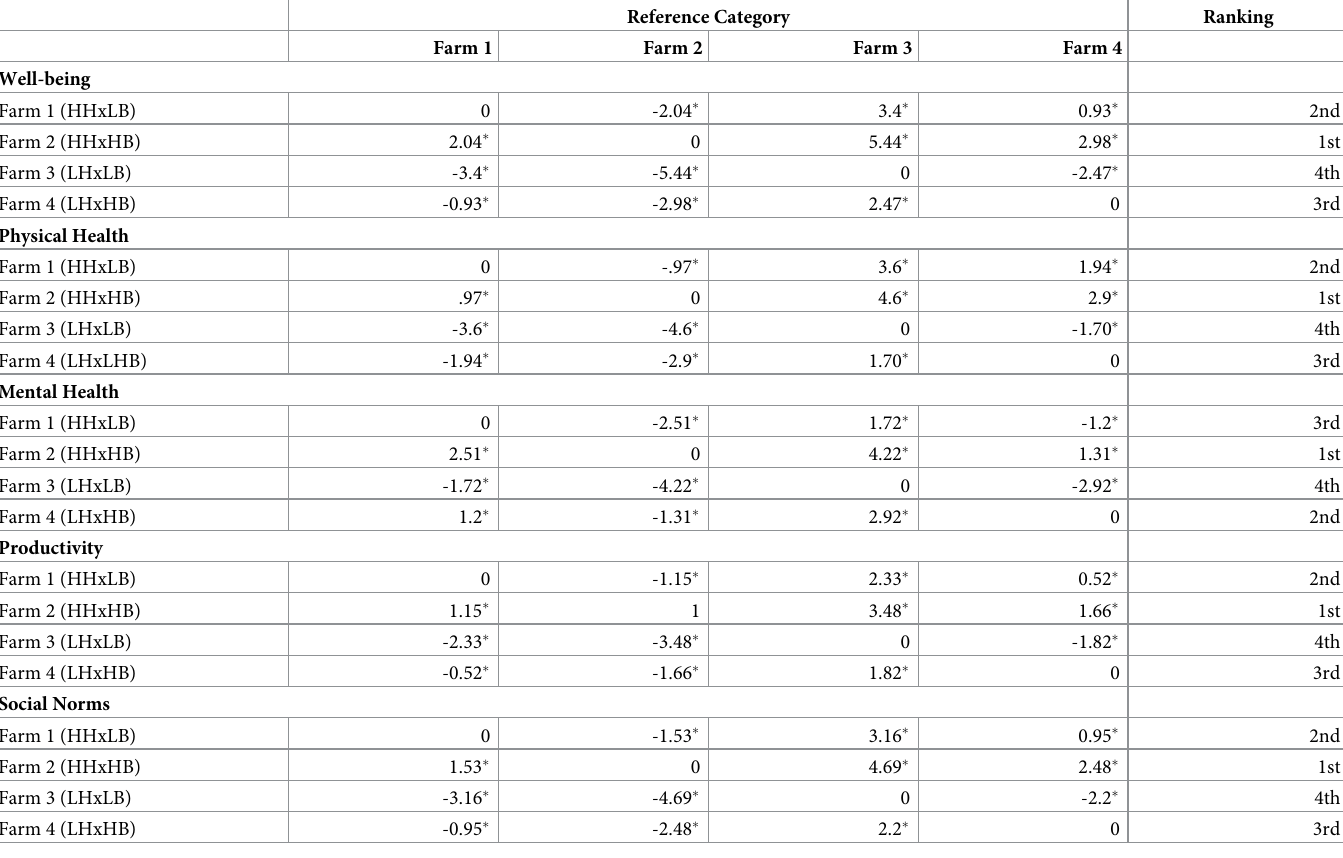
Table 3. Pairwise comparison of mean differences between vignette scenarios for judgements of welfare